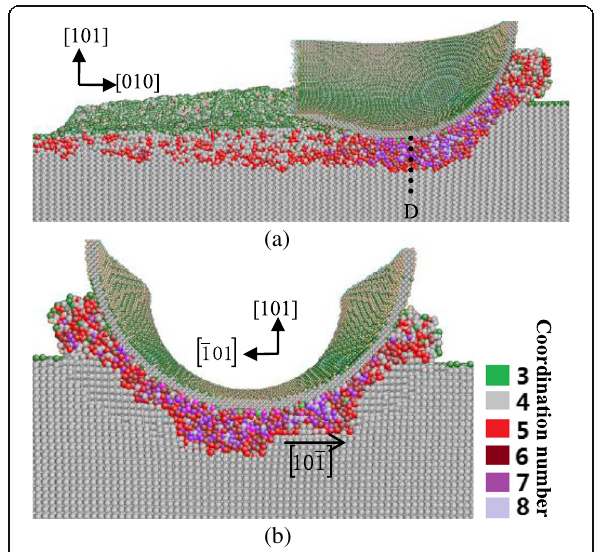
Fig. 9 Cross-sectional views of the subsurface deformation when nano-cutting along the [010] direction on the (101) plane. a On the (cid:4) (cid:5) plane, passing through the middle of the tool. b On the (010) 101 plane, passing through